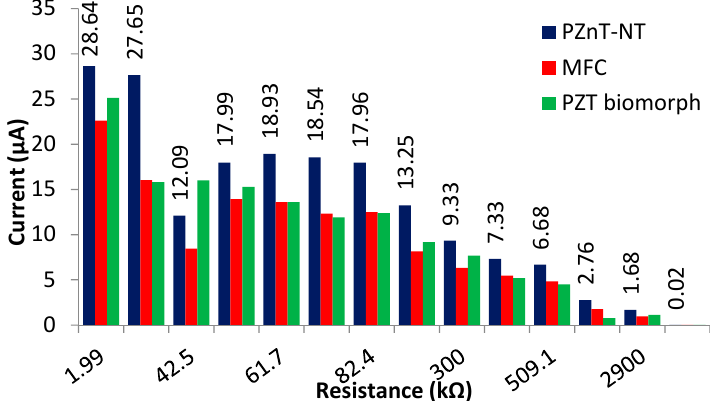
Figure 12. The generated current from the PZnT-NT, MFC, and lead zirconate titanate (PZT) bimorph.